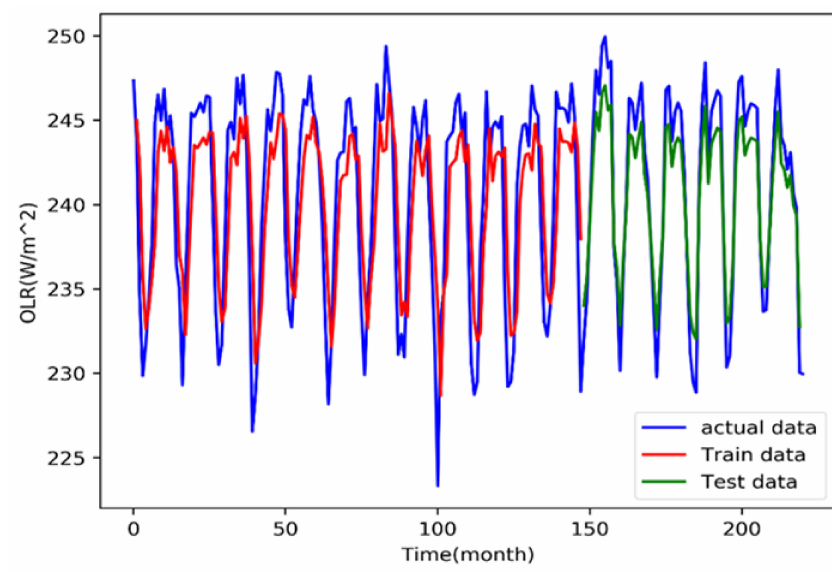
Figure 12. LSTM prediction model